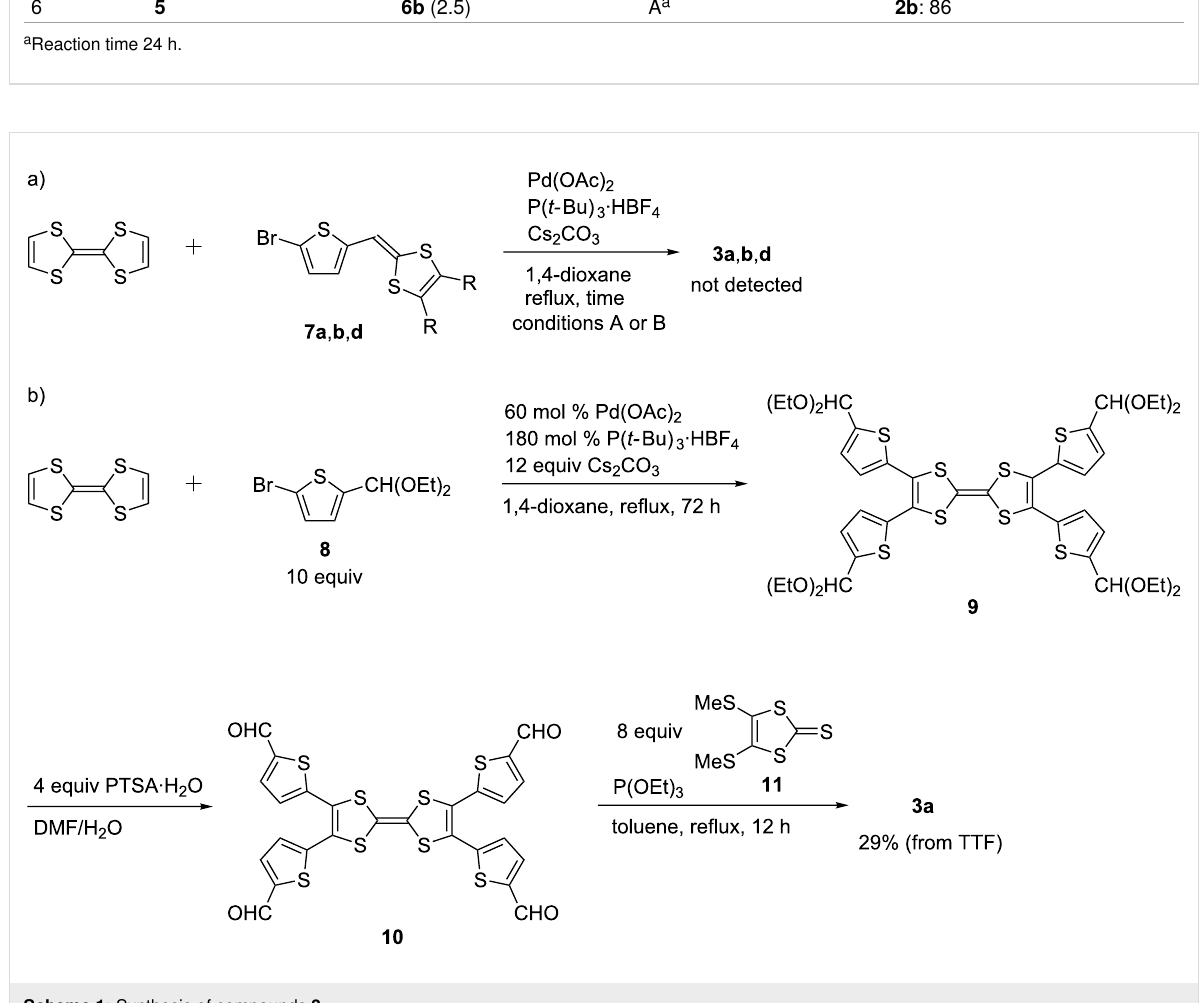
Scheme 1: Synthesis of compounds 3